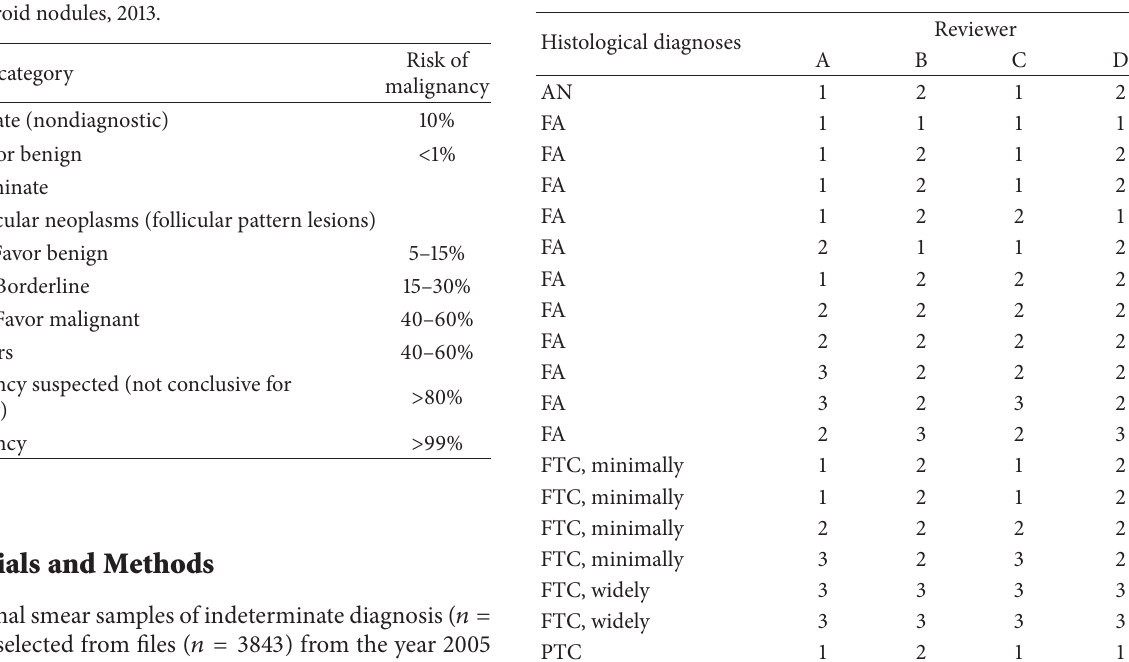
Table 2: Observer variability on 20 follicular pattern lesions by 4